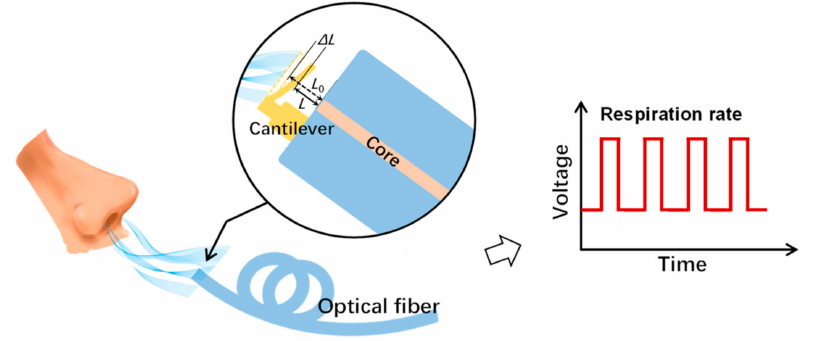
Figure 1. Schematic diagram of the proposed breath sensor. During the inhalation and exhalation cycles, the fiber-tip microcantilever deflects and recovers repeatedly. Thus, the respiration rate can be measured by recording the amplitude changes of the reflected light from the micro Fabry–P é rot interferometer formed by the microcantilever and the fiber